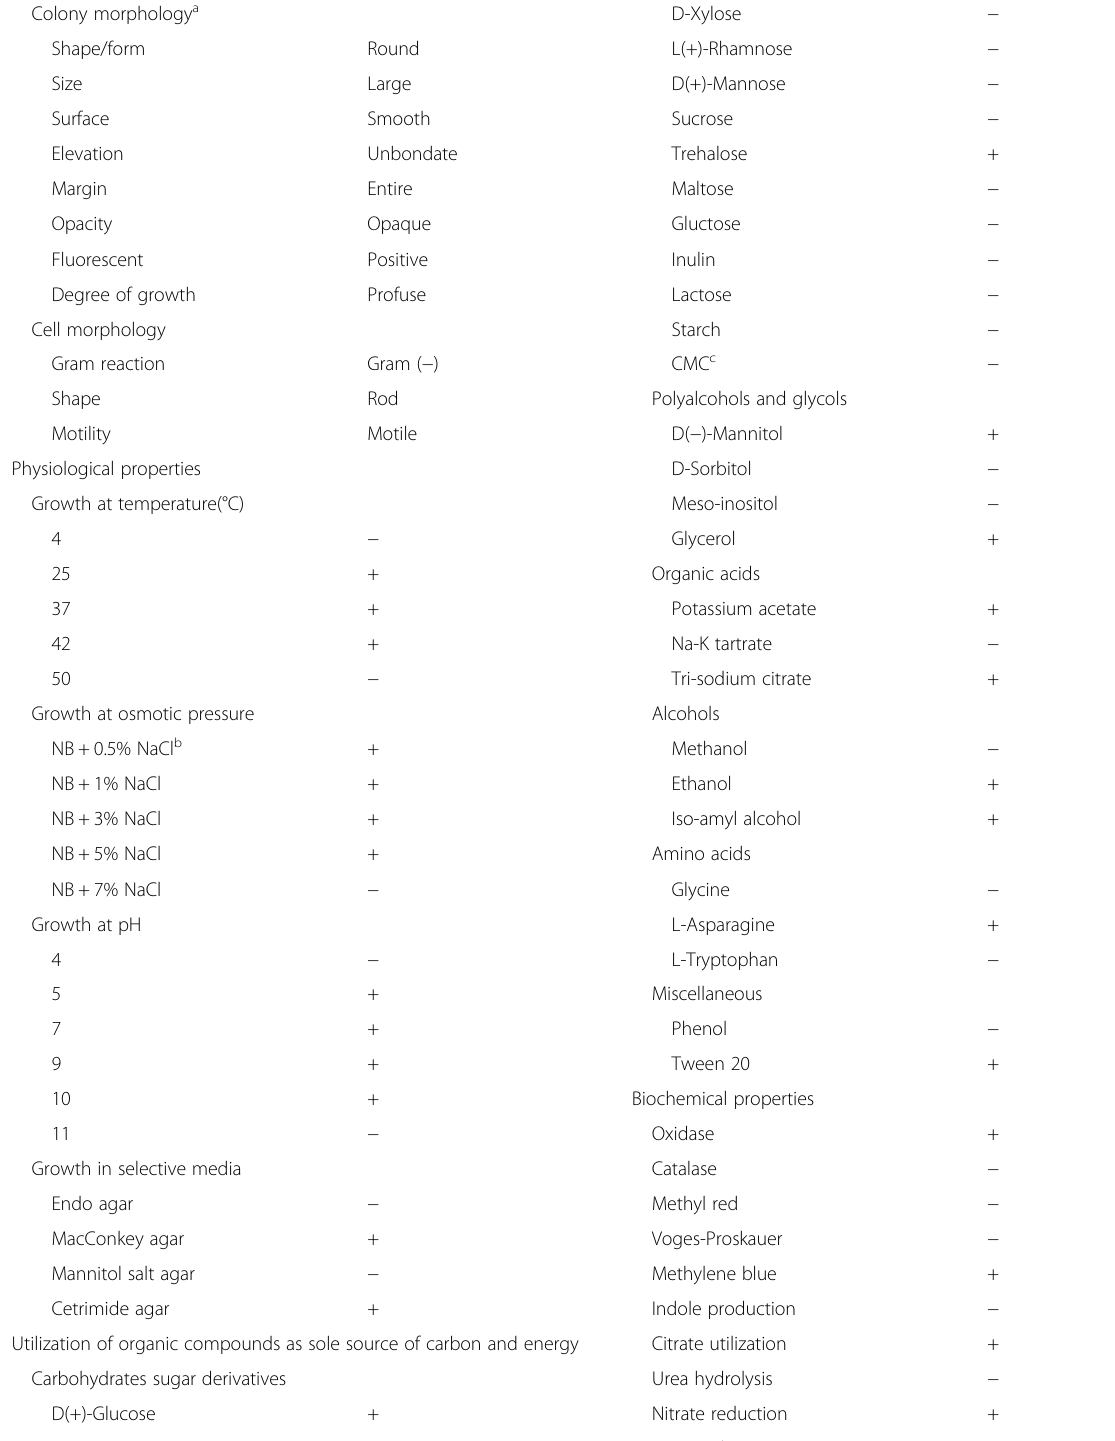
Table 2 Morphological, physiological, and biochemical characteristics of isolate BA5